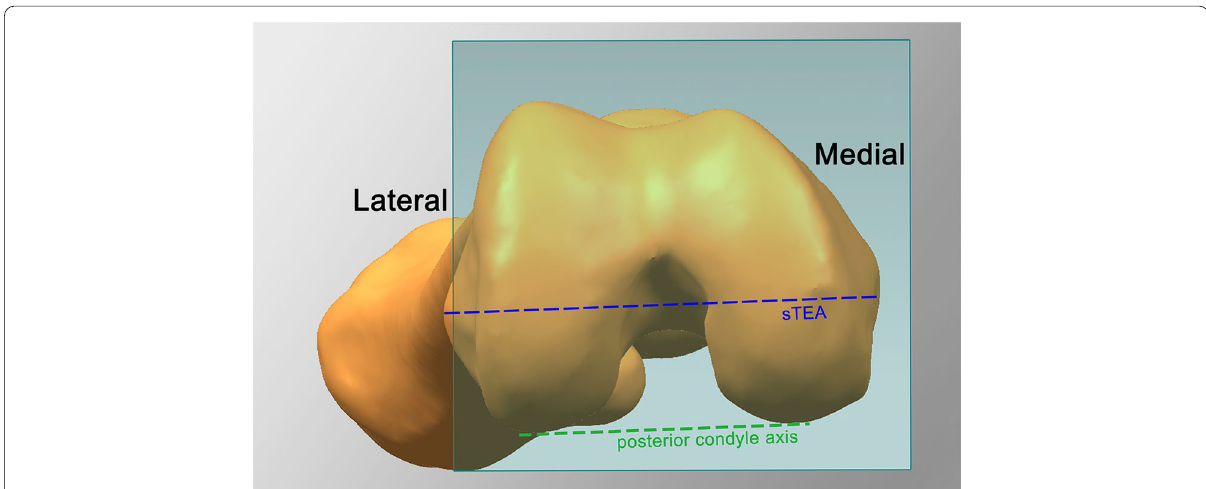
Fig. 3 The blue plane represents the transverse plain; the blue and green dashed line are the projections of sTEA and posterior condyle axis on transverse plain, respectively. The angle between the above two lines is denoted as posterior condylar angle (PCA)